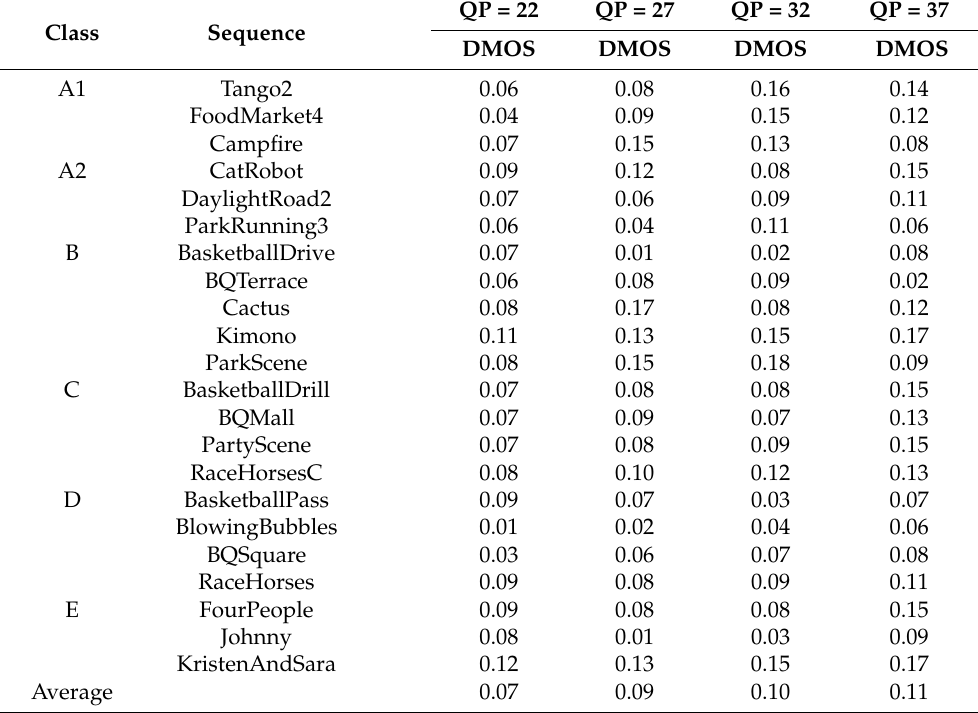
Table 7. Results of DSCQS